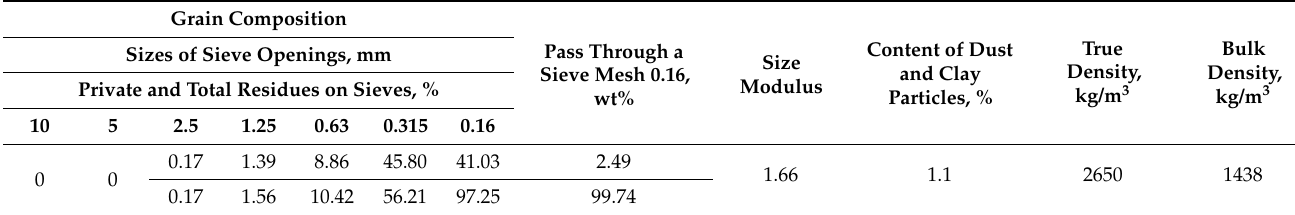
Table 2. Physical characteristics of fine